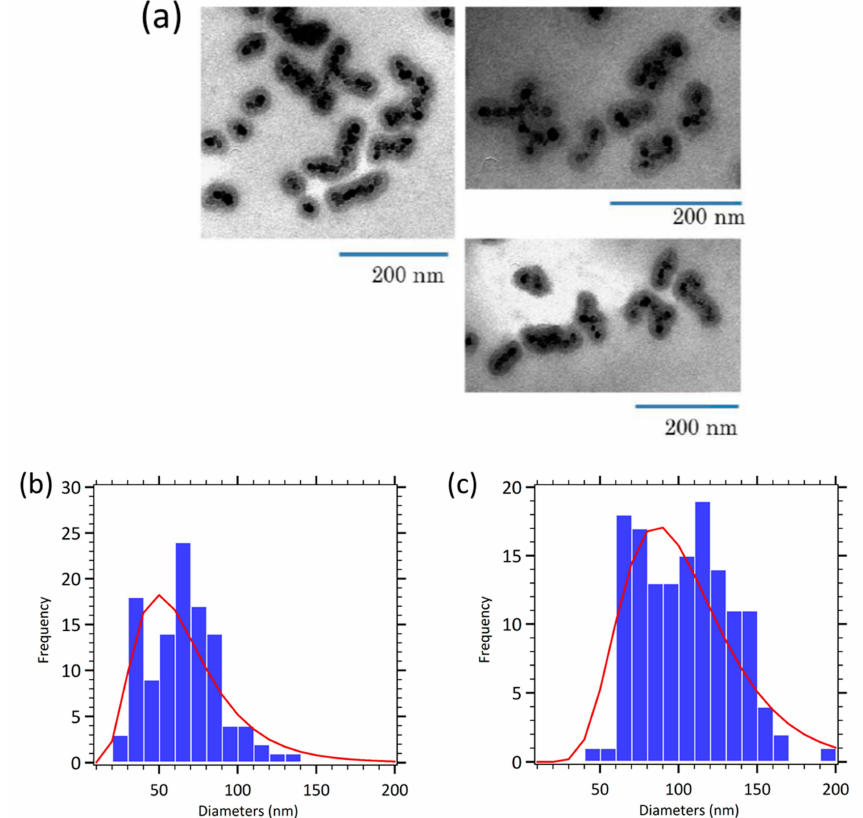
Figure A2. TEM images ( a ) and size distribution: ( b ) cores and ( c ) core–shell nanoparticles of core–shell nanoparticles γ -Fe 2 O 3 @SiO 2 PEG/NH 2